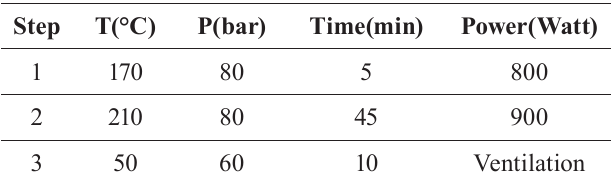
TABLE III - The microwave digestion parameters